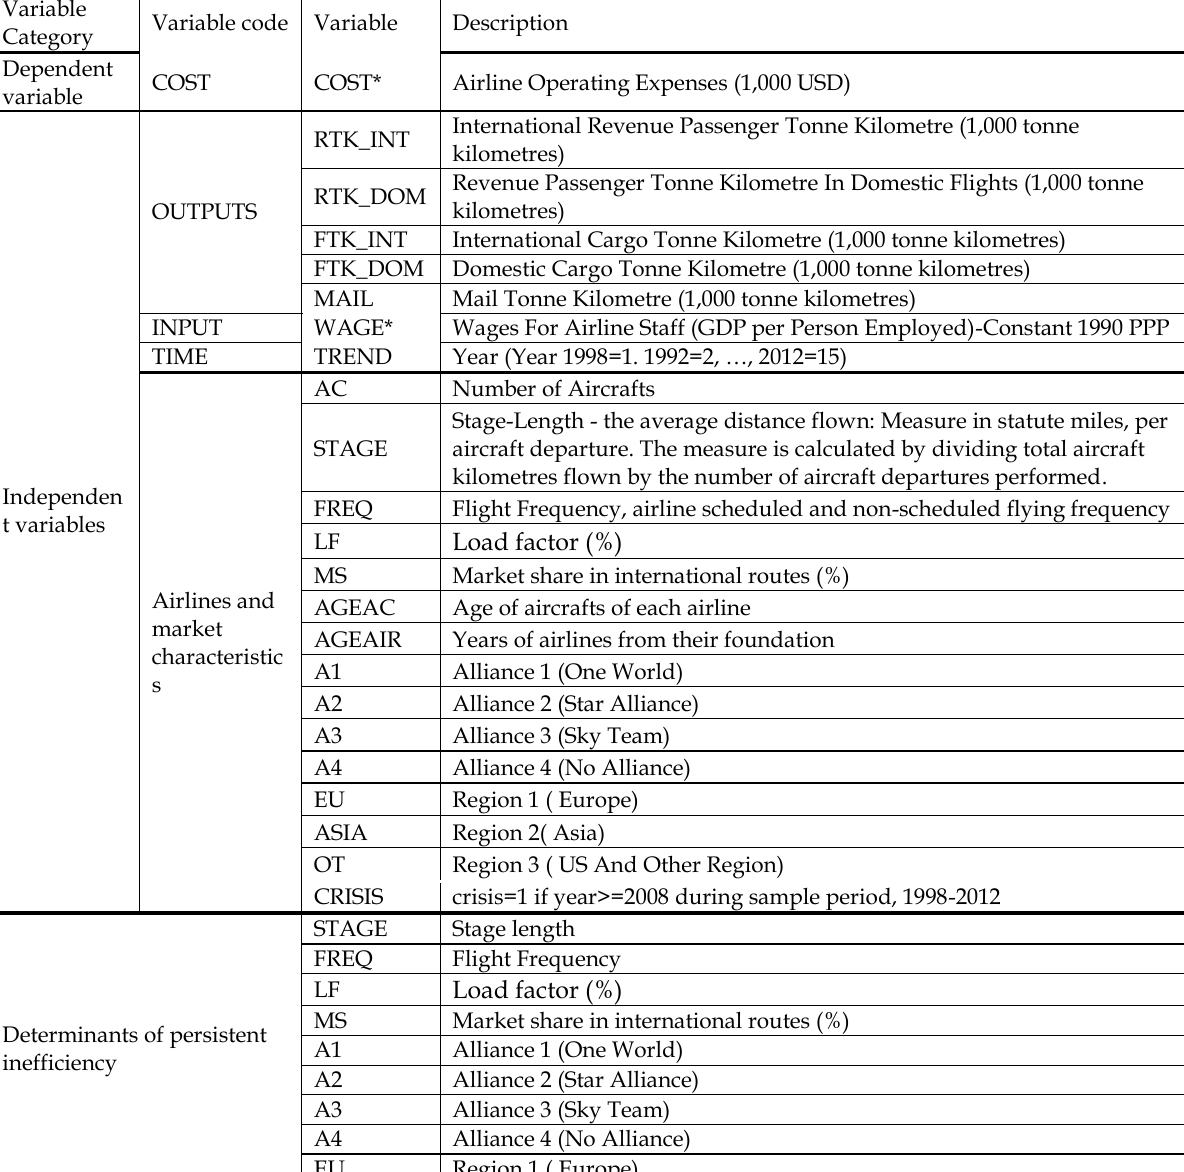
Description of variables used in specification of the stochastic frontier cost